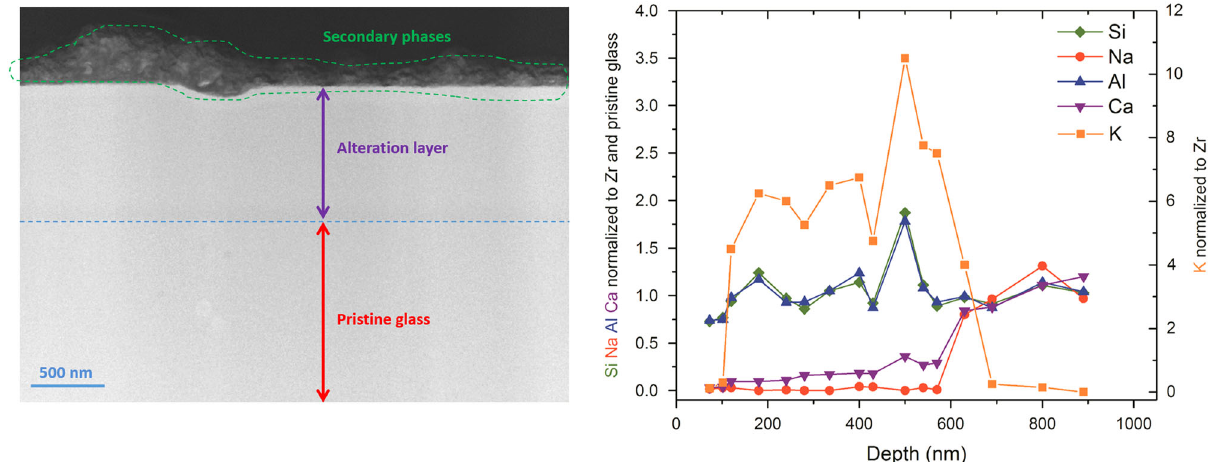
Fig. 7 TEM image on the left of polished side of day 246 monolith. Alteration layer of ~1 µm is seen with an additional 300 nm of secondary phases on the surface. The absence of contrast inside the alteration layer shows that there is no porosity formed within the alteration layer or that the pore size is smaller than 5 – 10 nm. The right fi gure shows the EDS pro fi le of this alteration region. Iron was not detected within the gel by this method